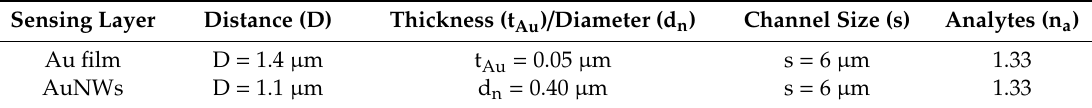
Figure 3. ( a ) and ( d ) show electric field distribution E y near film and NWs, respectively, ( b ) and ( e ) show the enlarged view; ( c ) and ( f ) show the E y field variation along the y-axis, for Au film and NWs, respectively. Table 1. Optimized structural parameters for the proposed